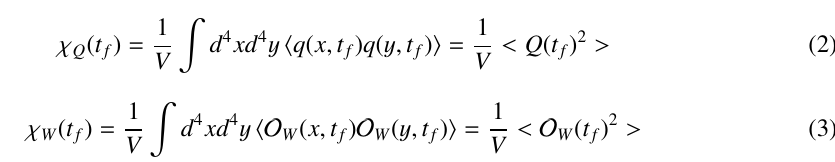
8 t f . Blue and red points are the (cid:31)